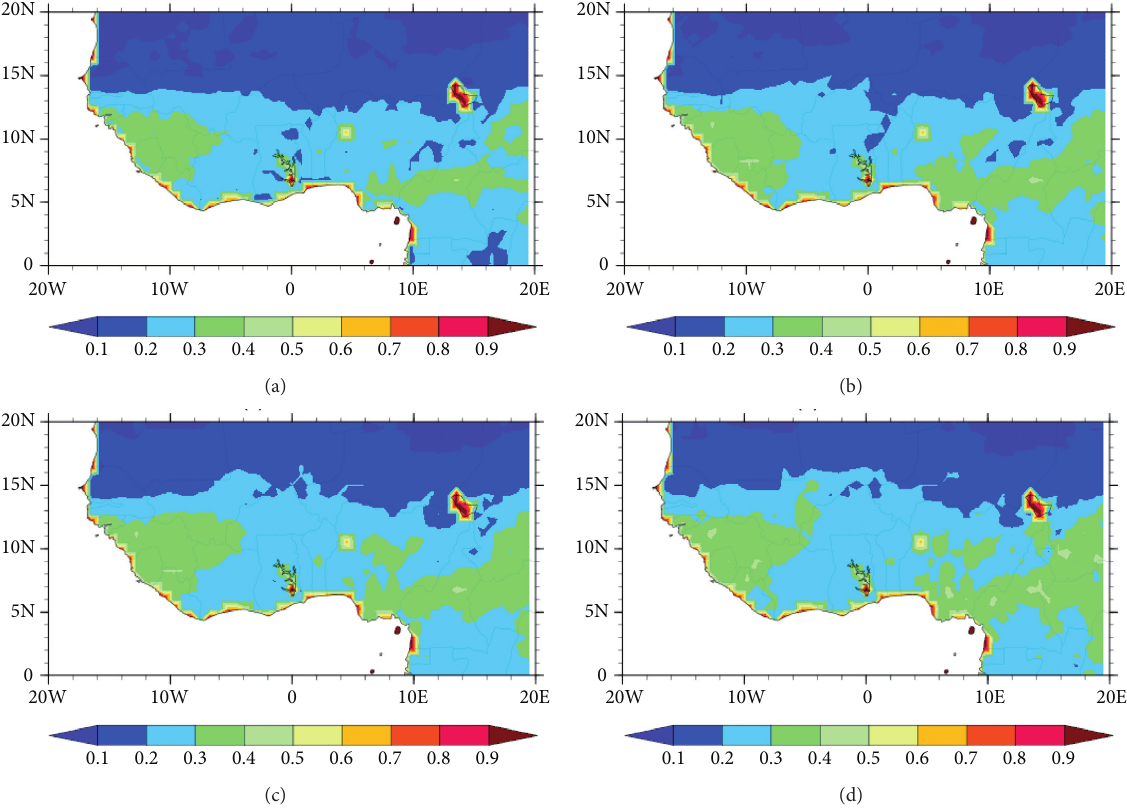
Figure 16: Spatial distribution of average soil moisture (m 3 /m 3 ) for July 16 th –Sept 29 th , 2012. (a) Naoh. (b) CLM4. (c) NaohMP. (d) NoahMP